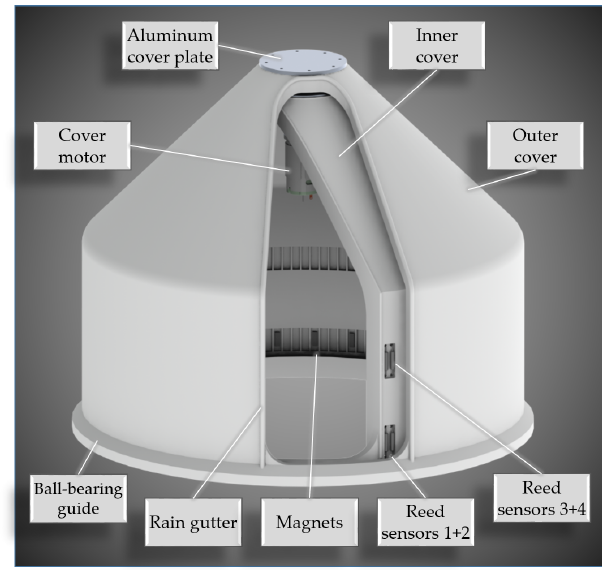
Figure 3. CAD model of the newly designed cover (outer and inner one) with a small opening and a steeper slope compared to the first version in Heinle and Chen (2018). With the help of the reed sensors 1 and 2, the relative position of the cover is calculated (in 10 ◦ steps). The second sensor indicates the direction. The reed sensors 3 and 4 are used to determine the absolute zero position each time before the cover